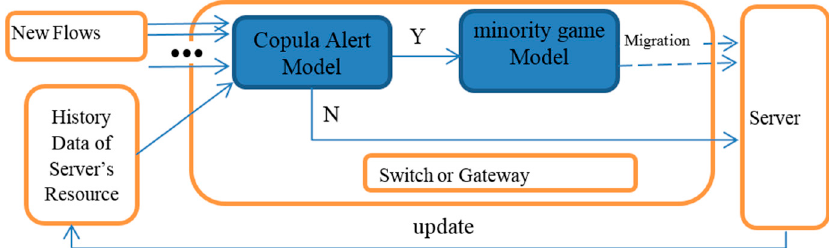
Figure 2. Schematic representation of the proposed model.